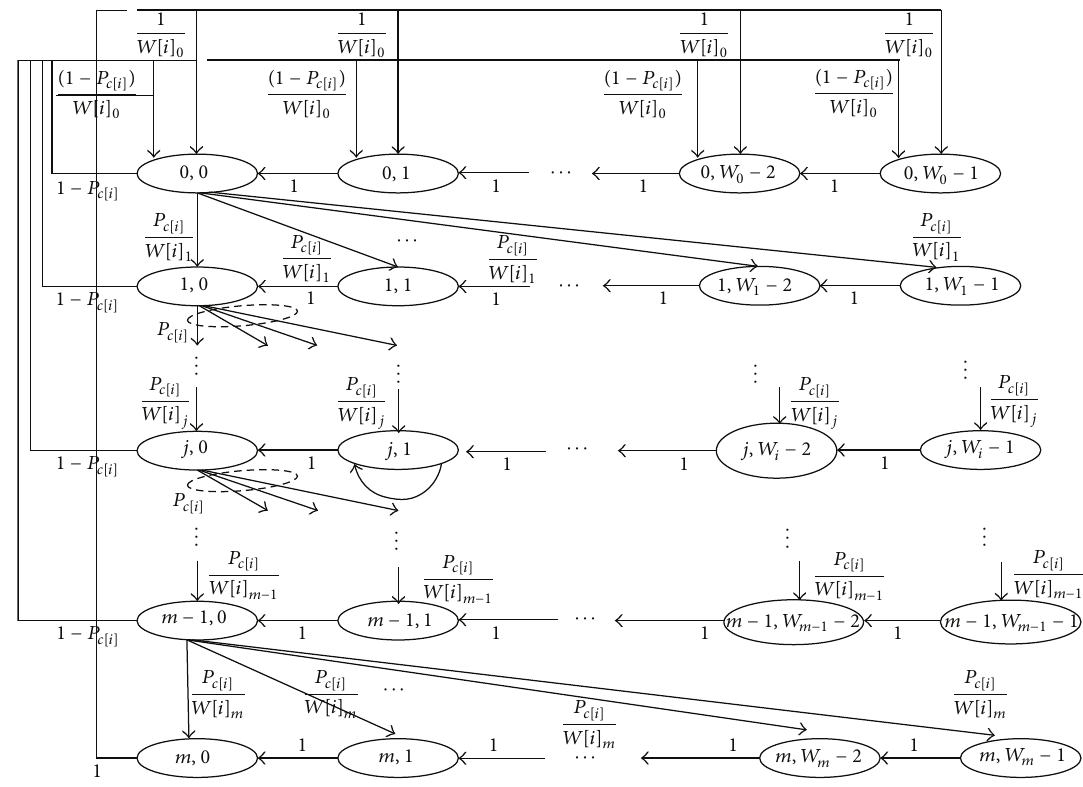
Figure 1: Markov chain model of EDCF in saturation